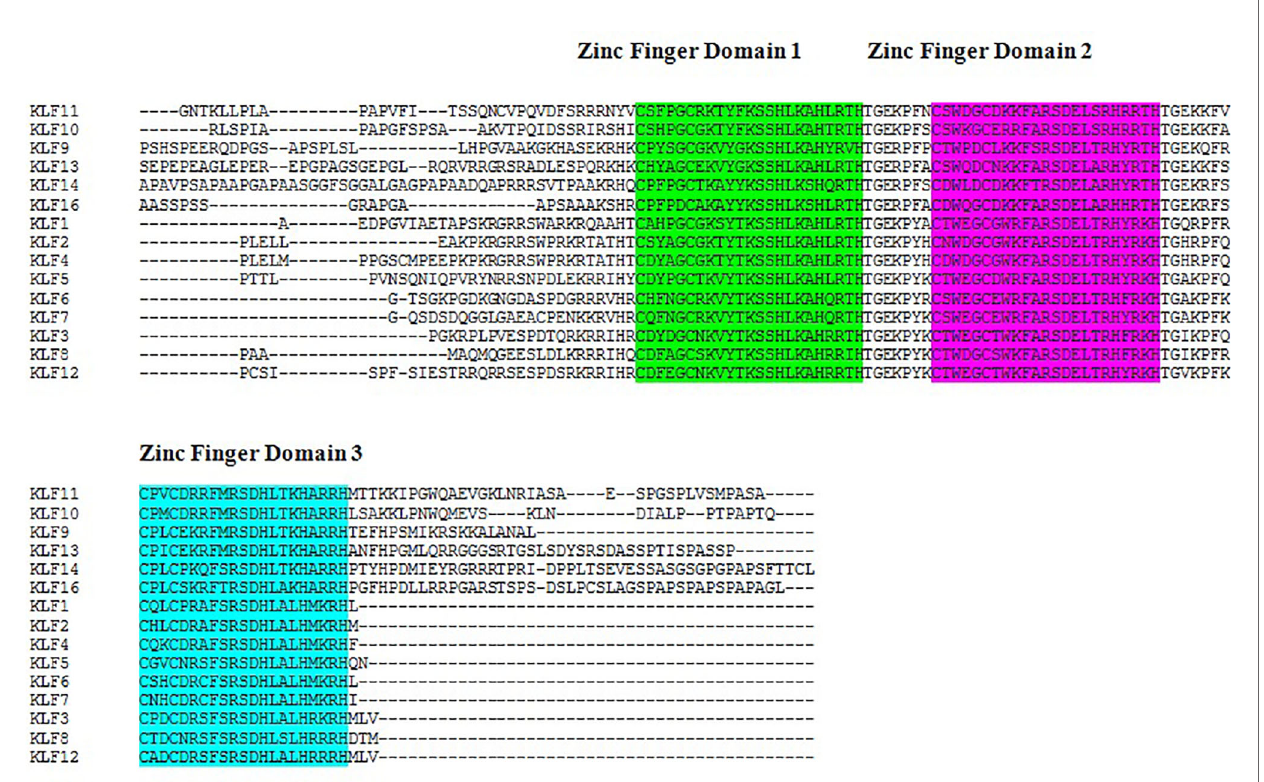
FIGURE 1 | Sequence alignment of Kruppel-like factors depicting the conserved domains obtained from Clustal Omega. Certain sequence alignments have been deleted for formatting. Zinc fi gure domain 1 (labeled green ), zinc fi gure domain 2 (labeled purple ), and zinc fi gure domain 3 (labeled blue ) are